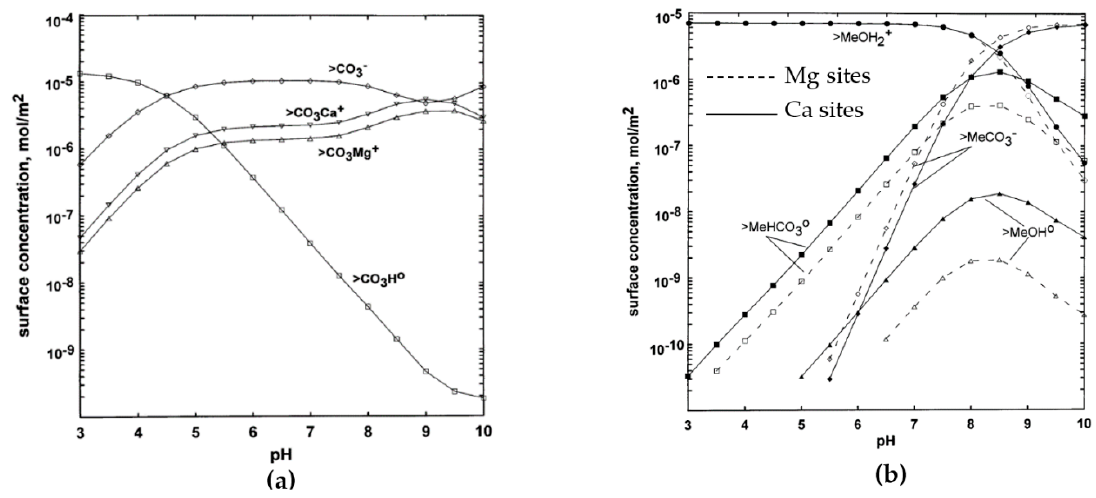
Figure 2. Calculated surface speciation of dolomite (0.01 mol/L NaCl, 10 − 3 M Ca 2+ , and Mg 2+ solution in equilibrium with pCO 2 = 10 − 3.5 atm). ( a ) Carbonate sites, and ( b ) metal sites [44]. Table 6. IEP values of dolomite and their measurement conditions.